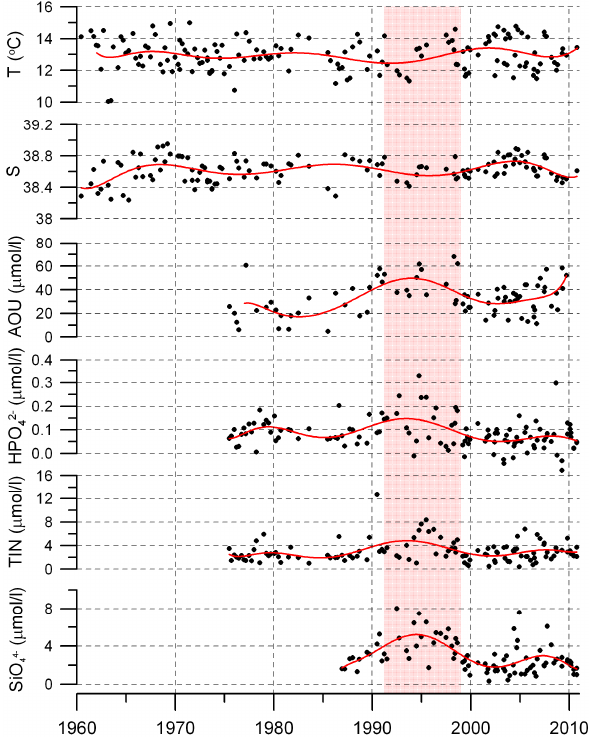
Fig. 4. As in Fig. 3, but for station P3 Figure 4. As in Fig. 3, but for station P3 (170 m).